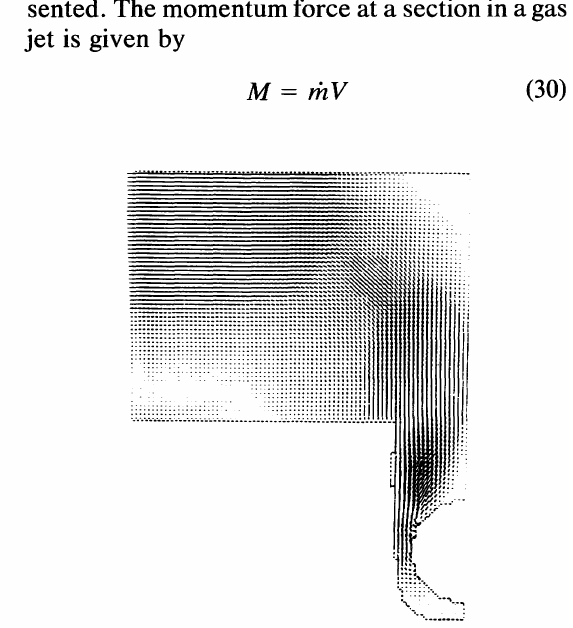
FIGURE 12 The flow pattern at an instant during the inflator discharge for nonaspirated